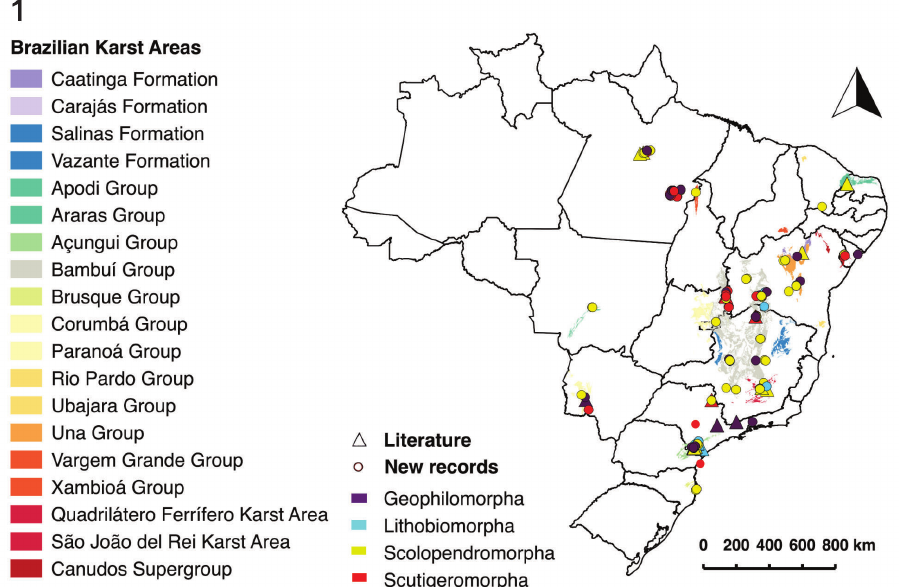
Figure 1. Map of Brazil showing the distribution of centipedes in different lithologies and geomorphological groups.